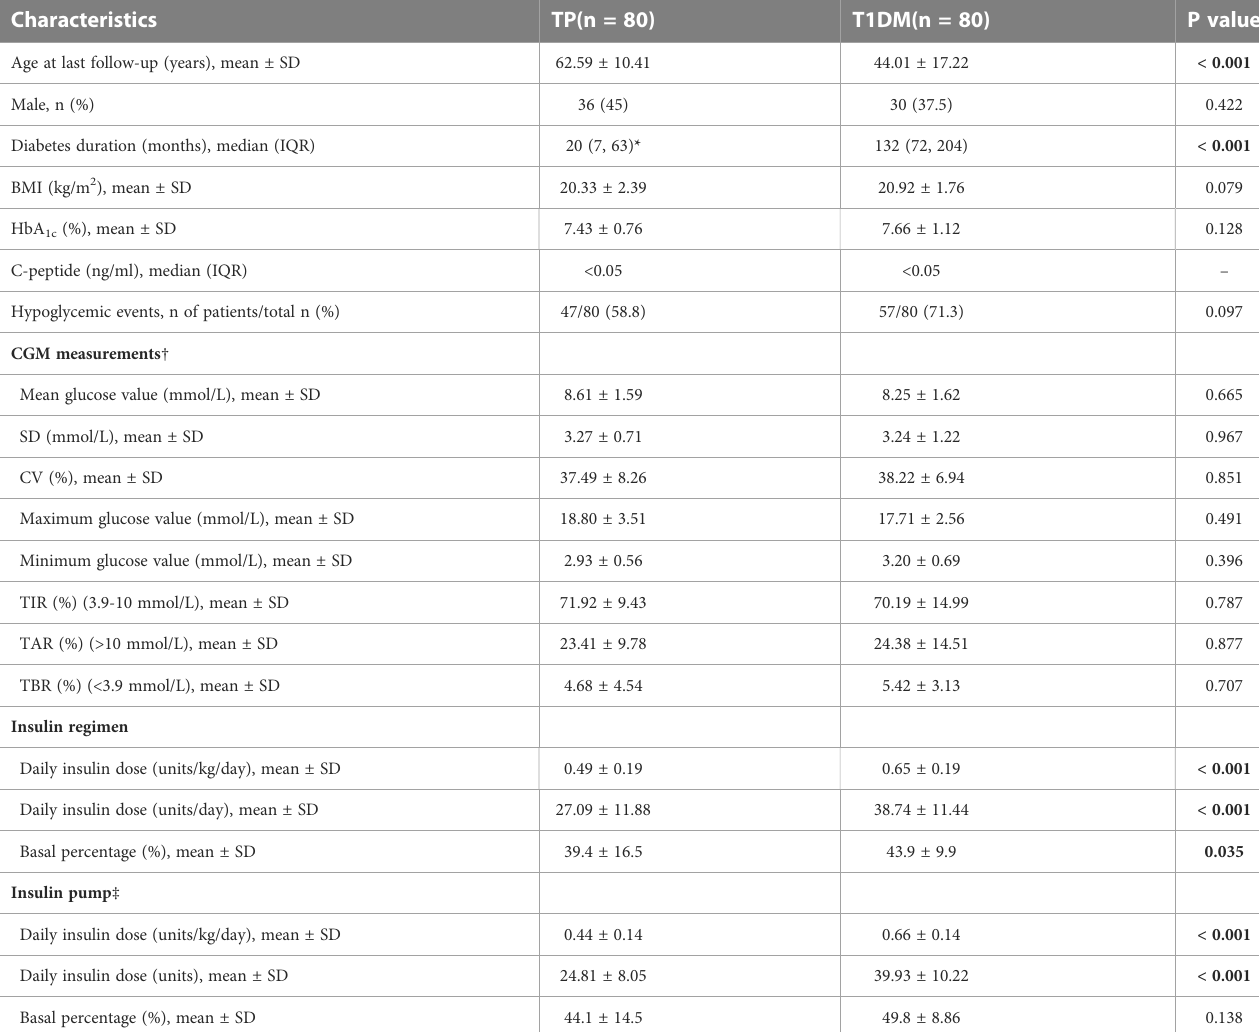
TABLE 3 Comparison of characteristics of diabetes mellitus after total pancreatectomy and type 1 diabetes in the long-term follow-up period. Characteristics